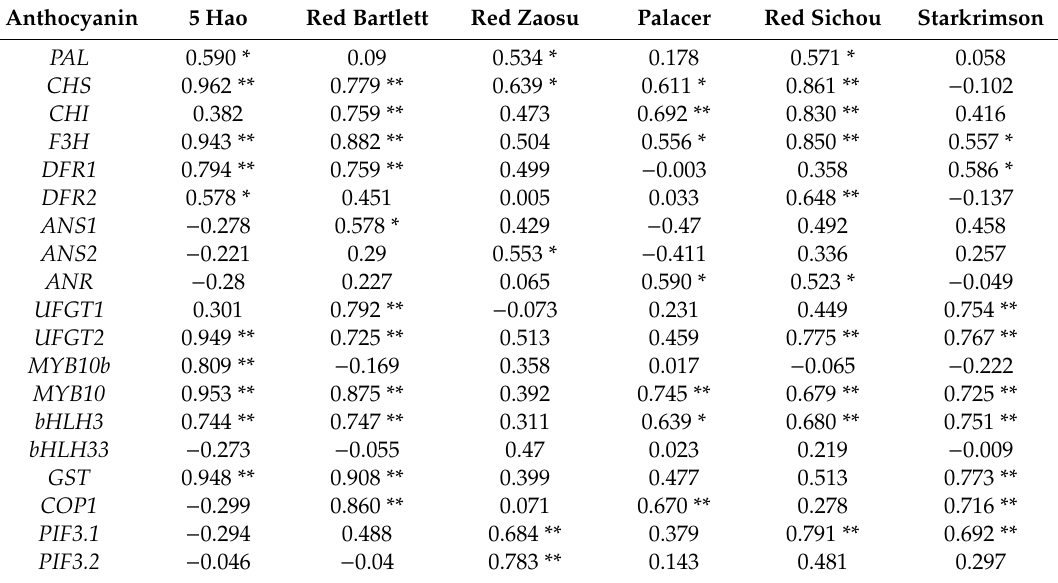
Table 1. Correlation analysis of the anthocyanin contents of six red pear cultivars and anthocyanin synthesis-related gene expression